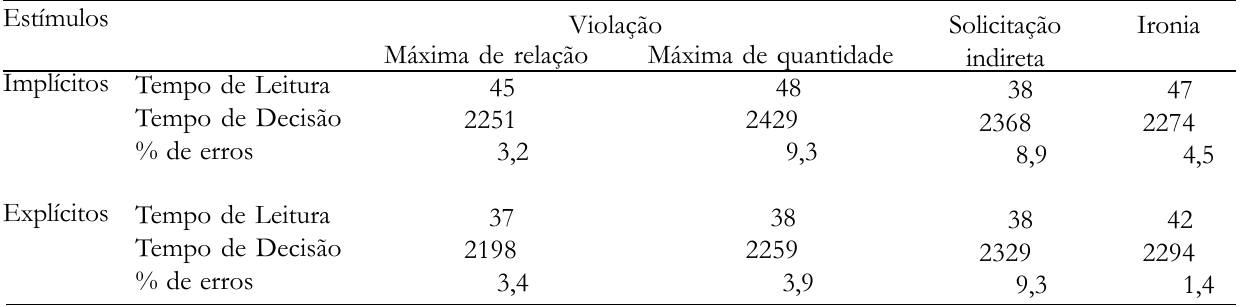
nos Estímulos Explícitos e